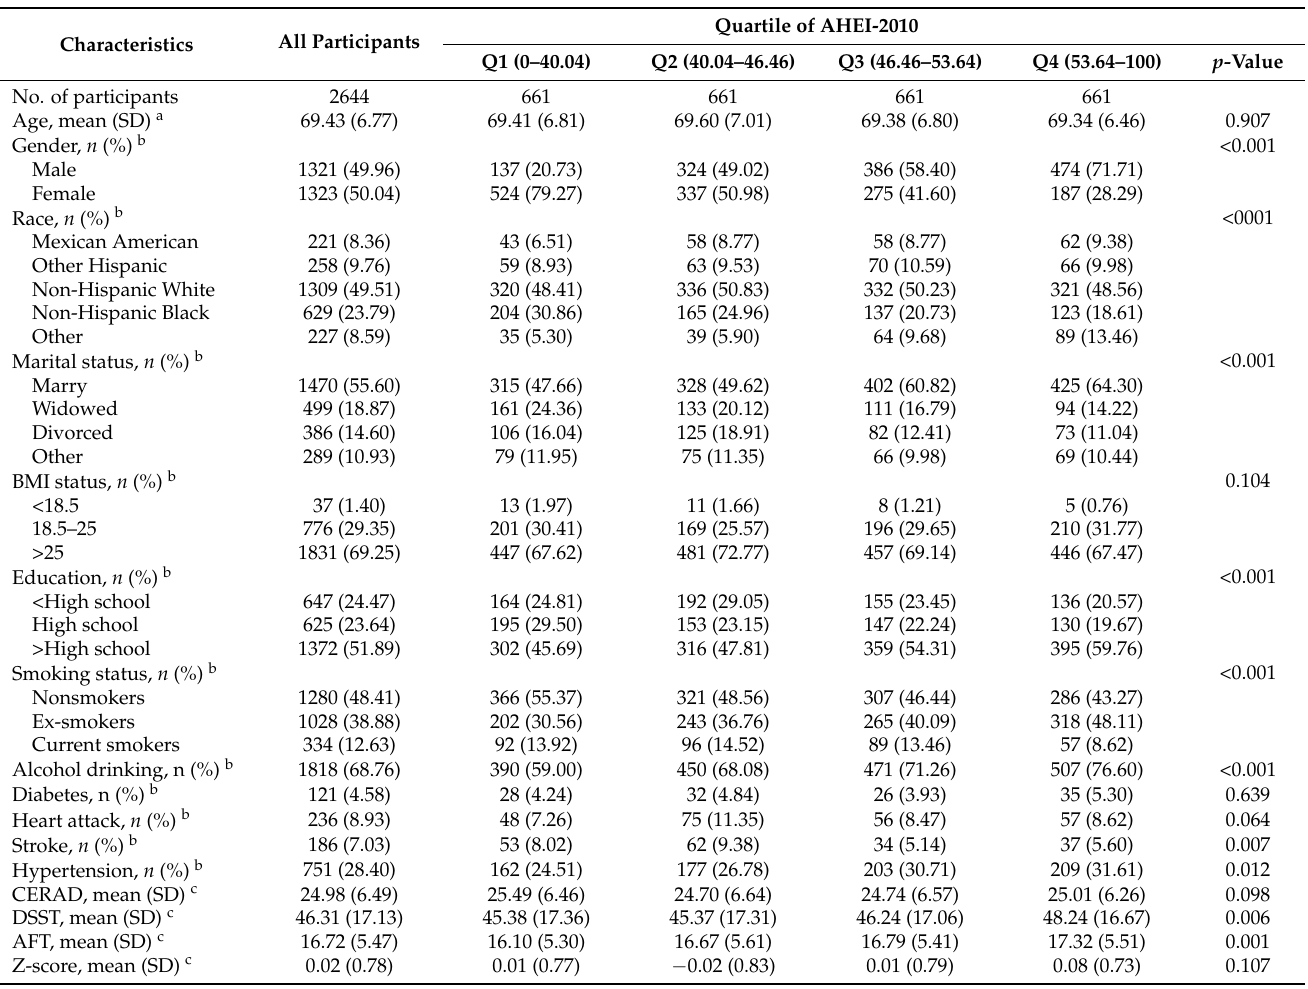
Table 1. Basic characteristics of the included sample ( n =